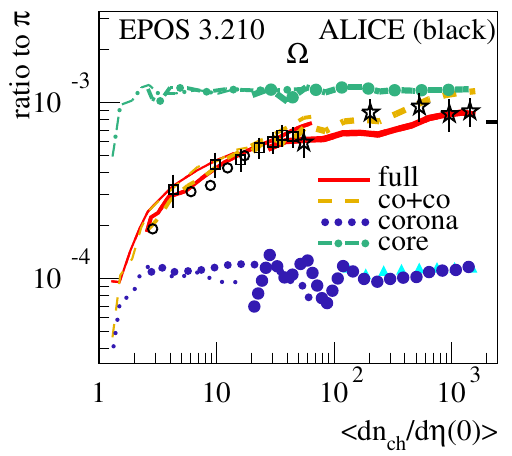
Figure 6. Particle to pion ratio for the Ω baryon versus multiplicity at mid-rapidity, for di ff erent contributions (core (dash-dotted), corona (dotted), core + corona (dashed) and all (core + corona + hadronic gas) (full)) from the EPOS simulations, for di ff erent systems (pp (thin), pPb (normal), PbPb (bold)). We also plot ALICE data from